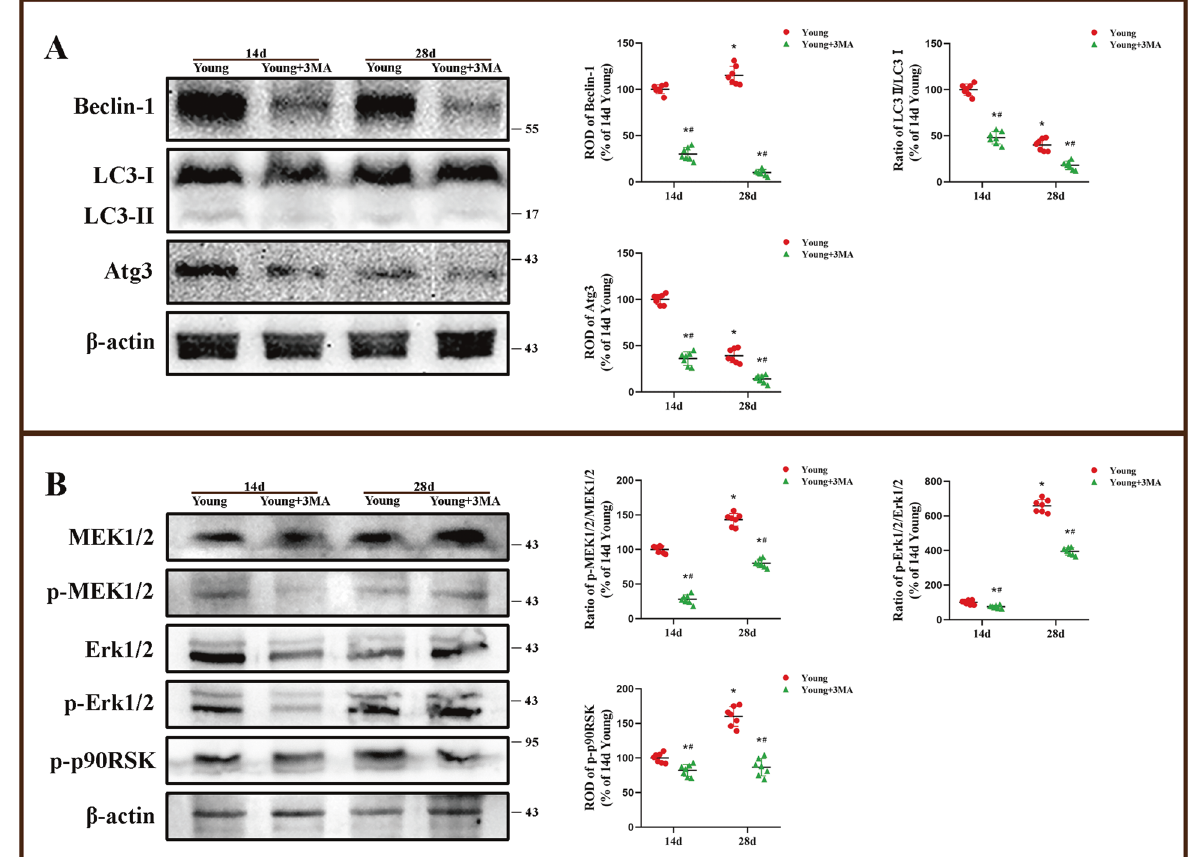
Fig. 7 Change of Erk1/2 signaling and autophagy-related protein levels by 3MA treatment. Western blot analysis of Beclin-1, LC3-I, LC3-II, and Atg3 in the hippocampus of the young gerbils treated with 3MA ( A ). Western blot analysis of p-MEK1/2, MEK1/2, p-Erk1/2, Erk1/2, and p-p90RSK in the hippocampus of the young gerbils treated with 3MA ( B ) ( n = 7 per group; * p < 0.05, signi fi cantly different from the 14-d young group, # p < 0.05, signi fi cantly different from the young group at the same reperfusion time). Bars indicate mean ±